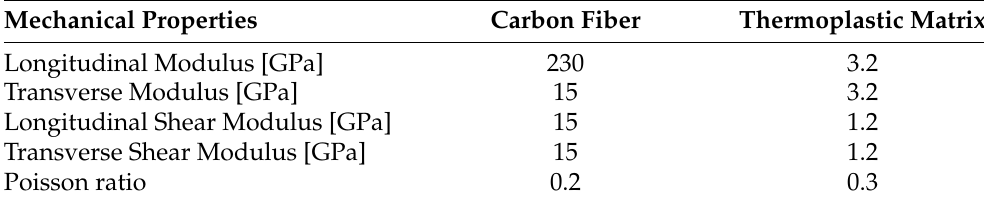
Table 5. Adopted mechanical properties of carbon fiber and resin matrix [7,8].